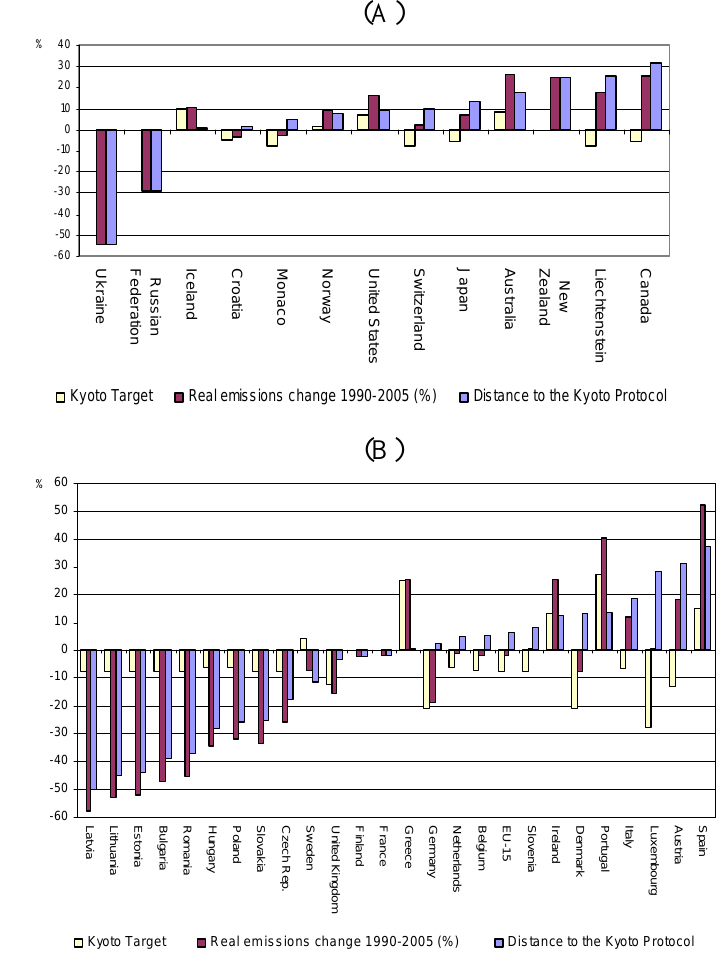
-e emissions for the period 1990-2005. (A). Annex B Countries Figure 2. Annex B CO 2 Verified Emissions 2004. B. European Countries Verified Emissions